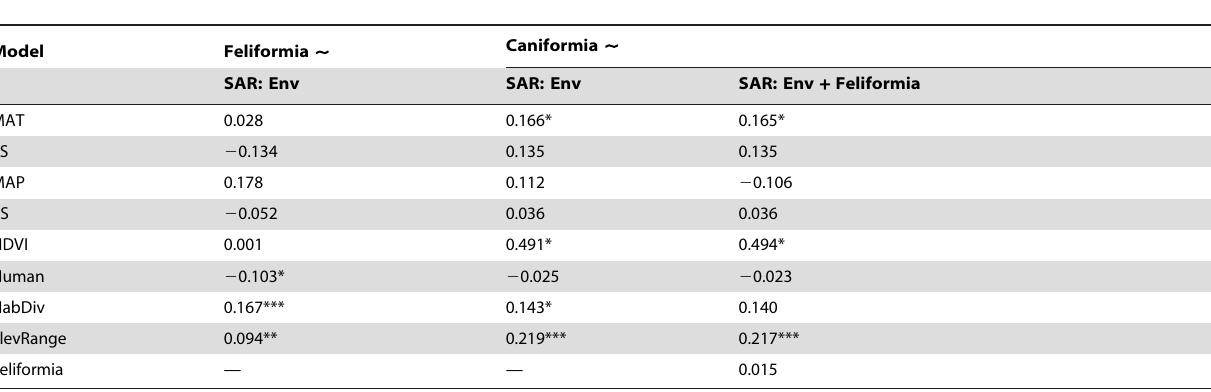
Table 3. Results of the simultaneous auto-regressive (SAR) error models of feliform and caniform species richness against environmental (ENV) predictors or these plus species richness of the competing group (Env + Feliformia).